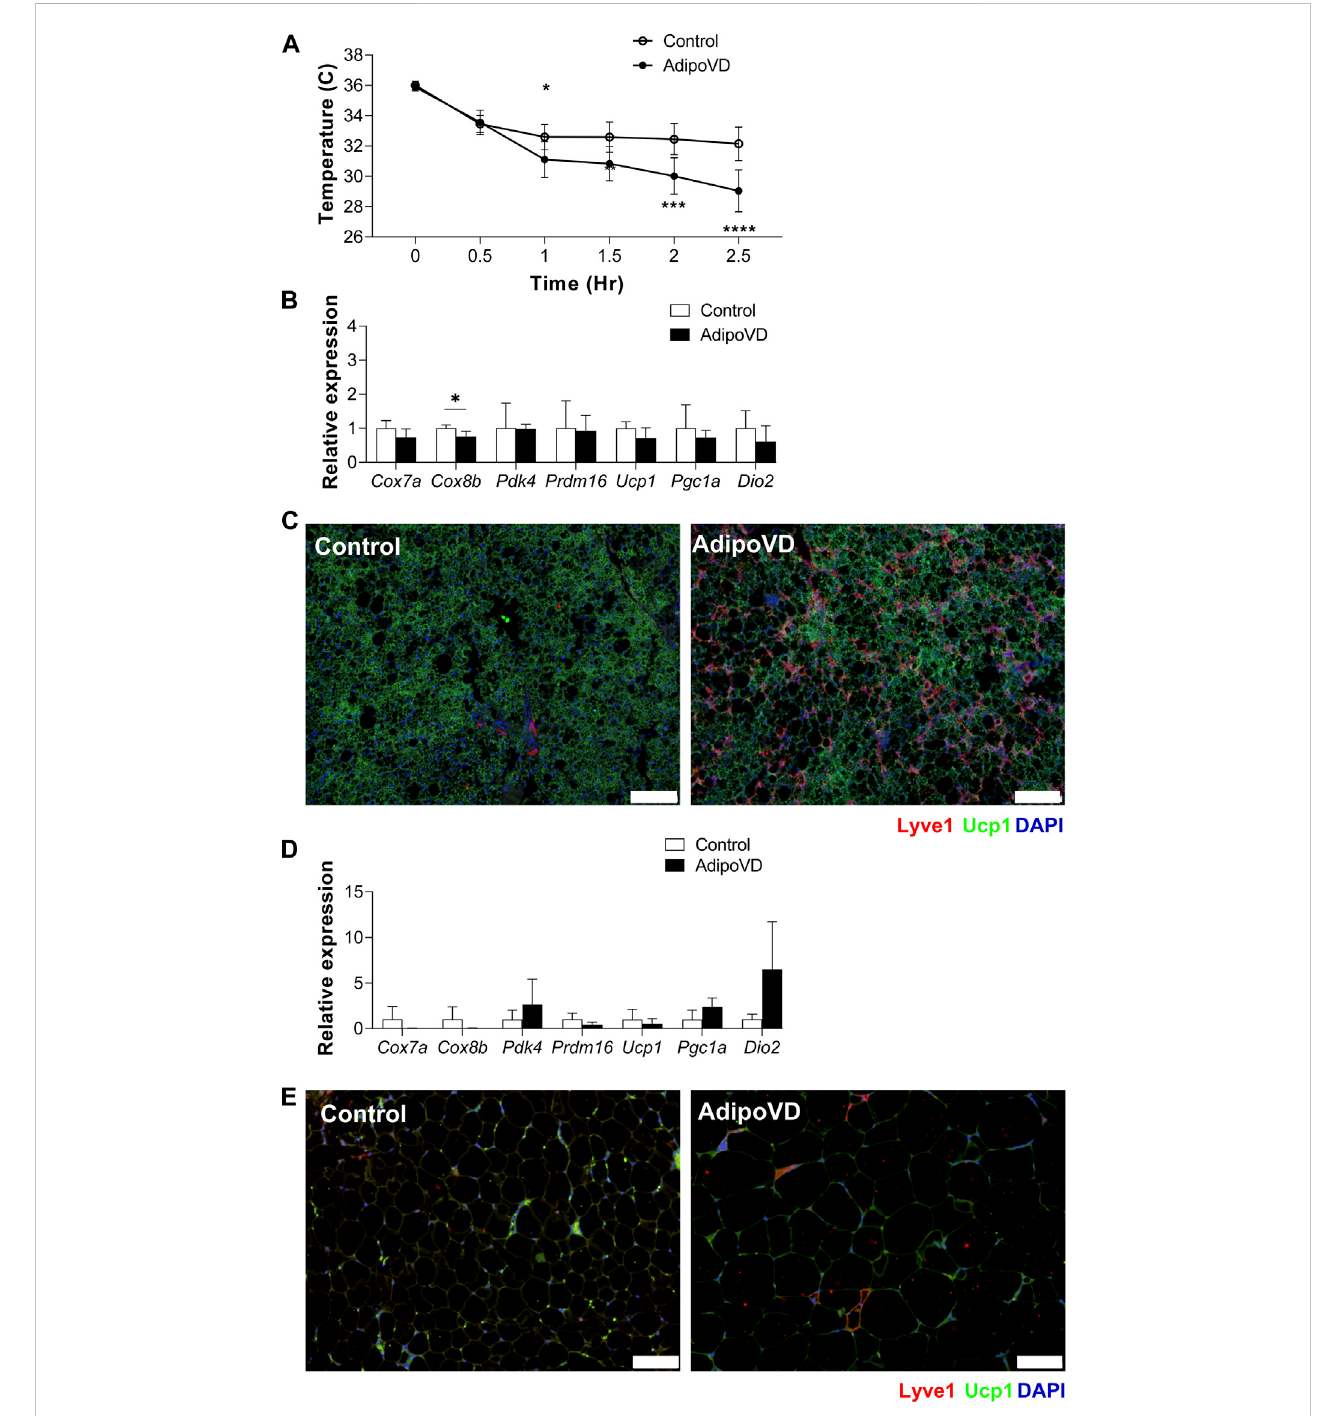
FIGURE 3 Temperature dysfunction in AdipoVD mice as a result of increased neurotensin levels. (A) Body temperature of Control and AdipoVD mice during acute undercoldexposureat4 ° C. (B) Browningandthermogenesis-associatedgeneexpressioninAdipoVDBATrelativetoControlsunderacutecoldexposure. (C) Immuno fl uorescence of potential thermogenesis (green; UCP-1) and lymphatic (red; LYVE-1) from BAT depot of Control and AdipoVD following cold exposure. (C) Immuno fl uorescenceofUCP-1(green)andlymphatics(red;LYVE-1)fromBATdepotofControlandAdipoVDfollowingcoldexposure. (D) Browning and thermogenesis-associated gene expression in AdipoVD SQAT relative to Controls following cold exposure. (E) Immuno fl uorescence of potentialthermogenesis(green;UCP-1)andlymphatic(red;LYVE-1)fromSQATdepotofControlandAdipoVDfollowingcoldexposure. (A – E) n =10control/ n = 7 AdipoVD. Blue = DAPI. Bars = 100